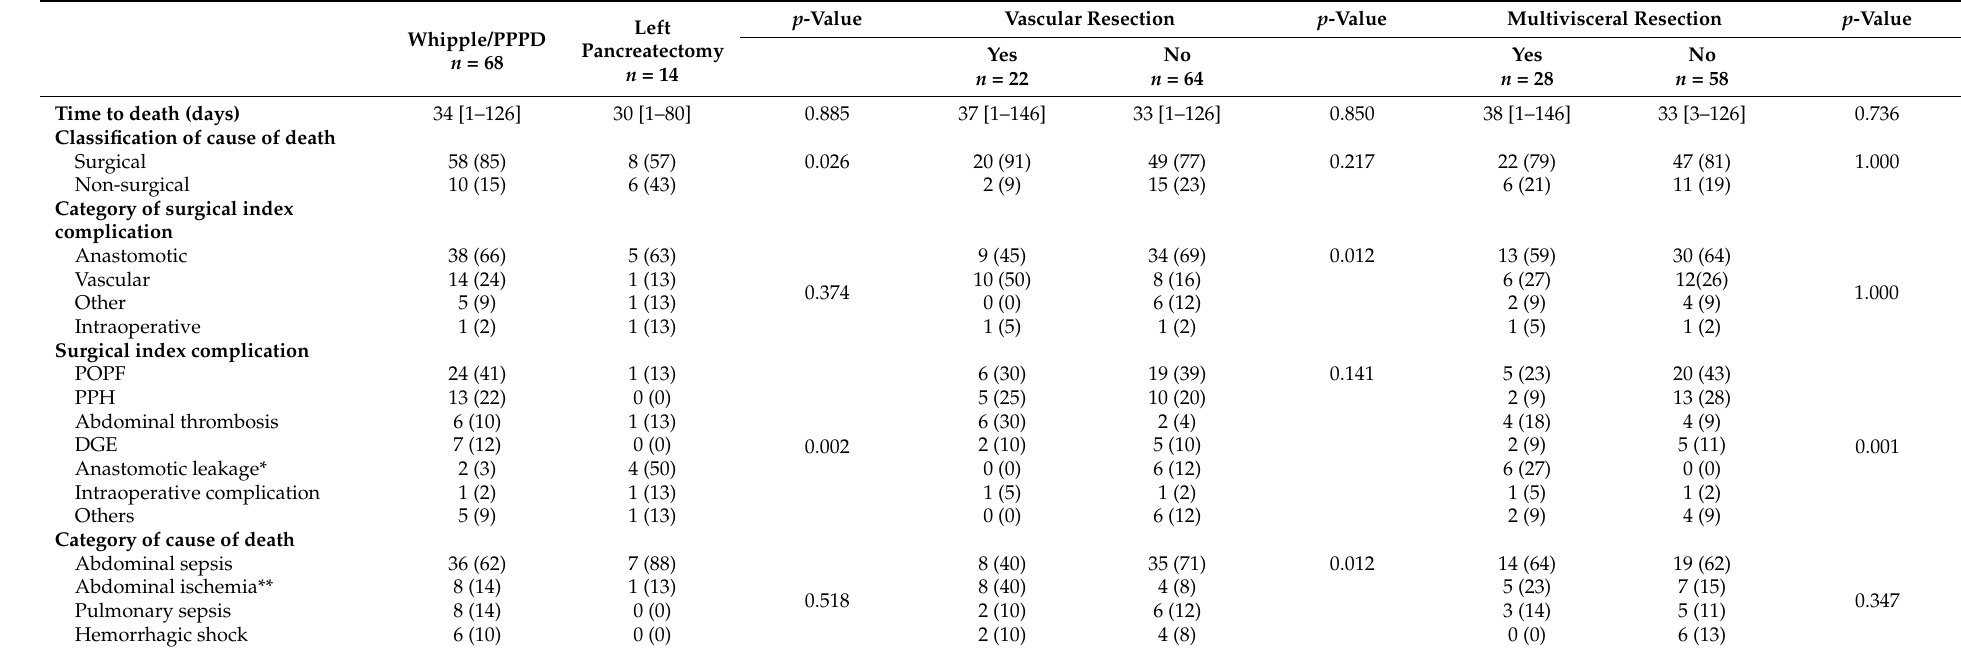
Table 5. Distribution of questionnaire responses according to surgical